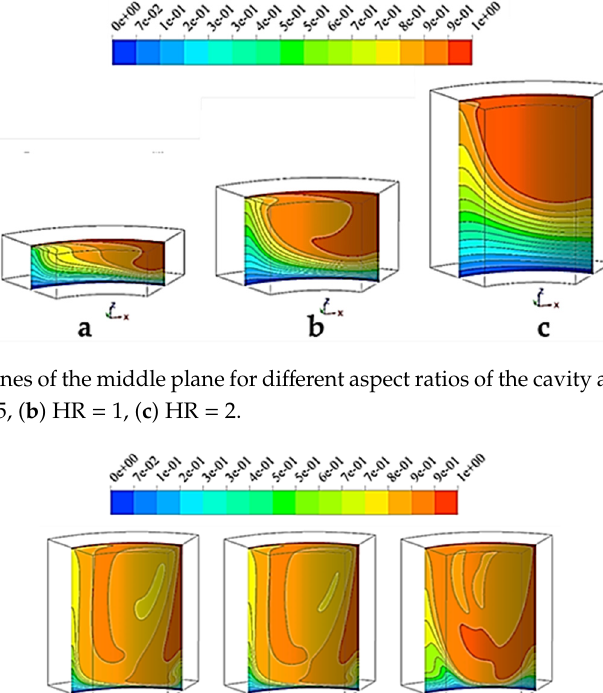
Figure 5. Isotherm lines of the middle plane for different aspect ratios of the cavity at Re = 100, Ra = 1e4, φ = 0%. ( a ) HR = 0.5, ( b ) HR = 1, ( c ) HR = 2.